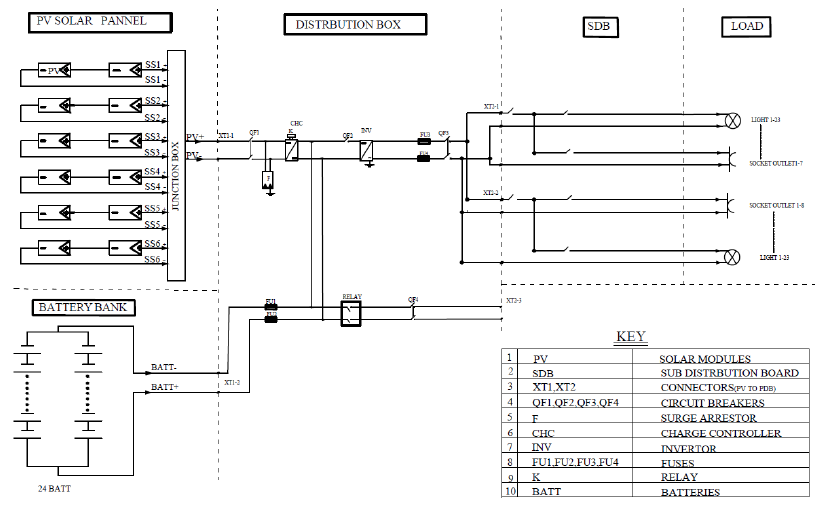
Figure 1. Circuit diagram of the health center PV system [12].